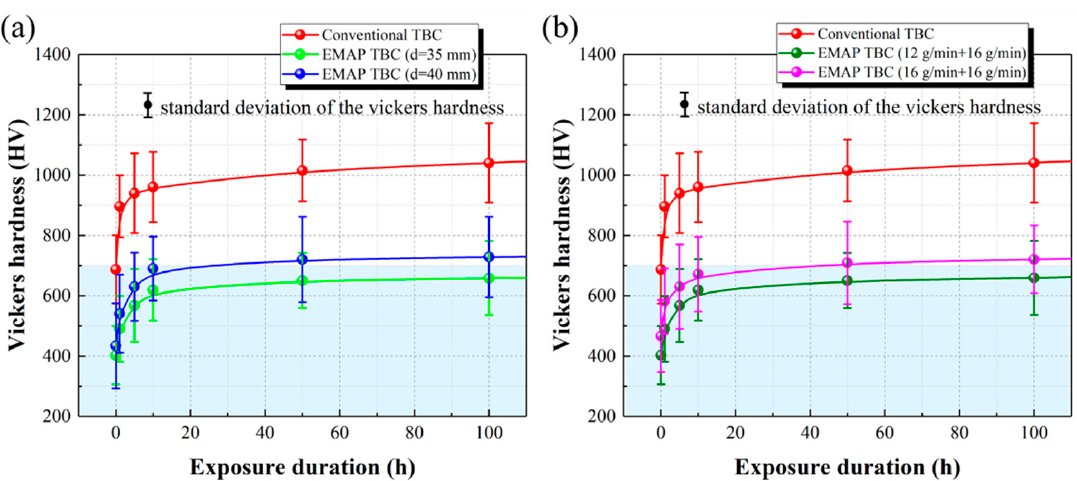
Figure 10. Evolution of the Vickers microhardness of the conventional TBC and EMAP TBCs with thermal exposure duration under 1300 °C: ( a ) conventional TBC and EMAP TBCs prepared with a different distance between powder feeder 1 and powder feeder 2. ( b ) Conventional TBC and EMAP TBCs prepared with different feeding rates of powder feeder 1 and powder feeder 2.